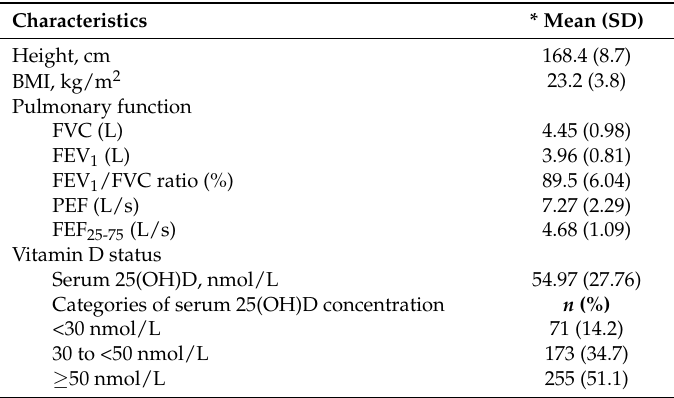
Table 2. Description of participants’ characteristics.